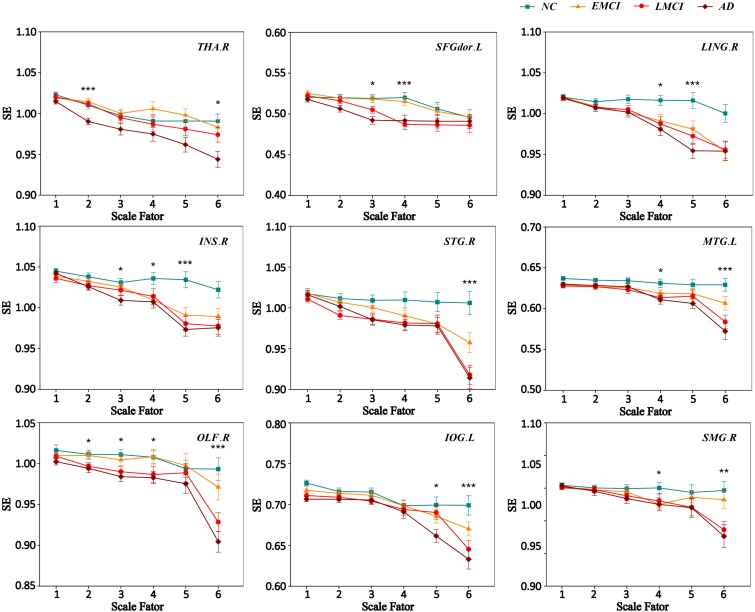
MSE curve across scale factor 1–6 for four groups. Each point represents group average SE. The error bar represents the standard error of MSE within the group. ∗ indicates p < 0.05. ∗∗indicates p < 0.05. ∗∗∗ indicates p < 0.001.